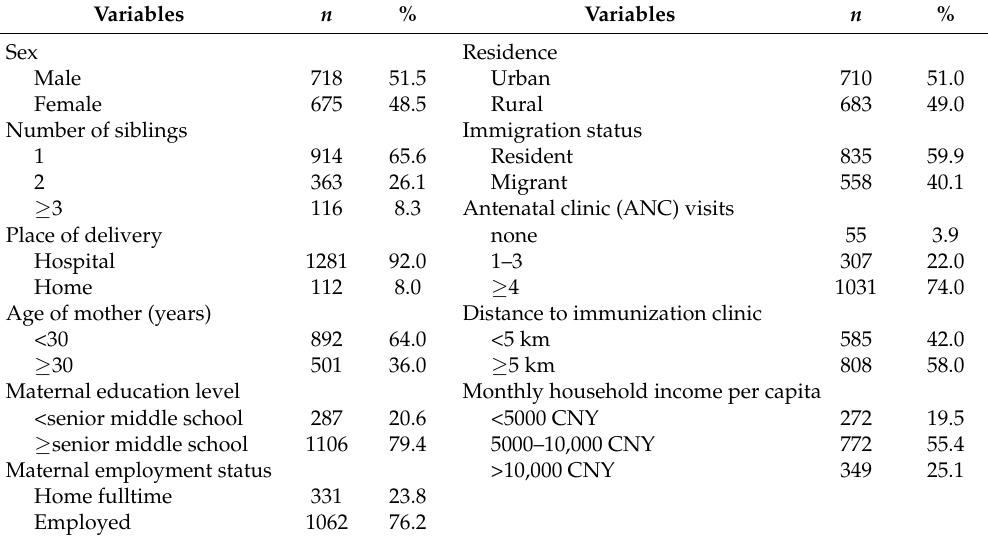
Table 1. Summary distribution of the demographic characteristics of surveyed children with immunization cards (N = 1393).